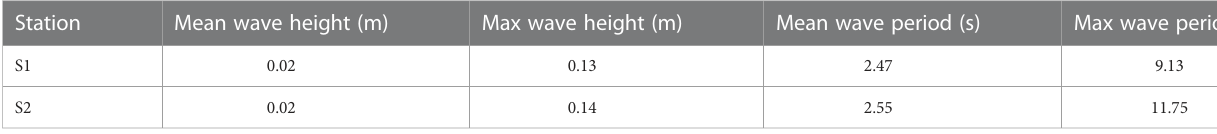
TABLE 1 Wave data during the observation periods.